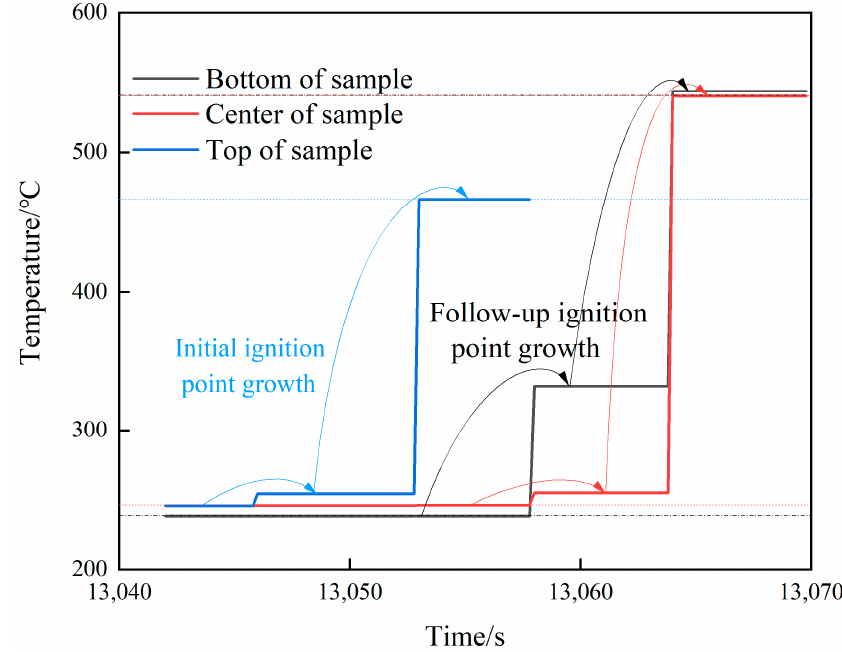
Figure 8. Temperature–time curve of shot 2.